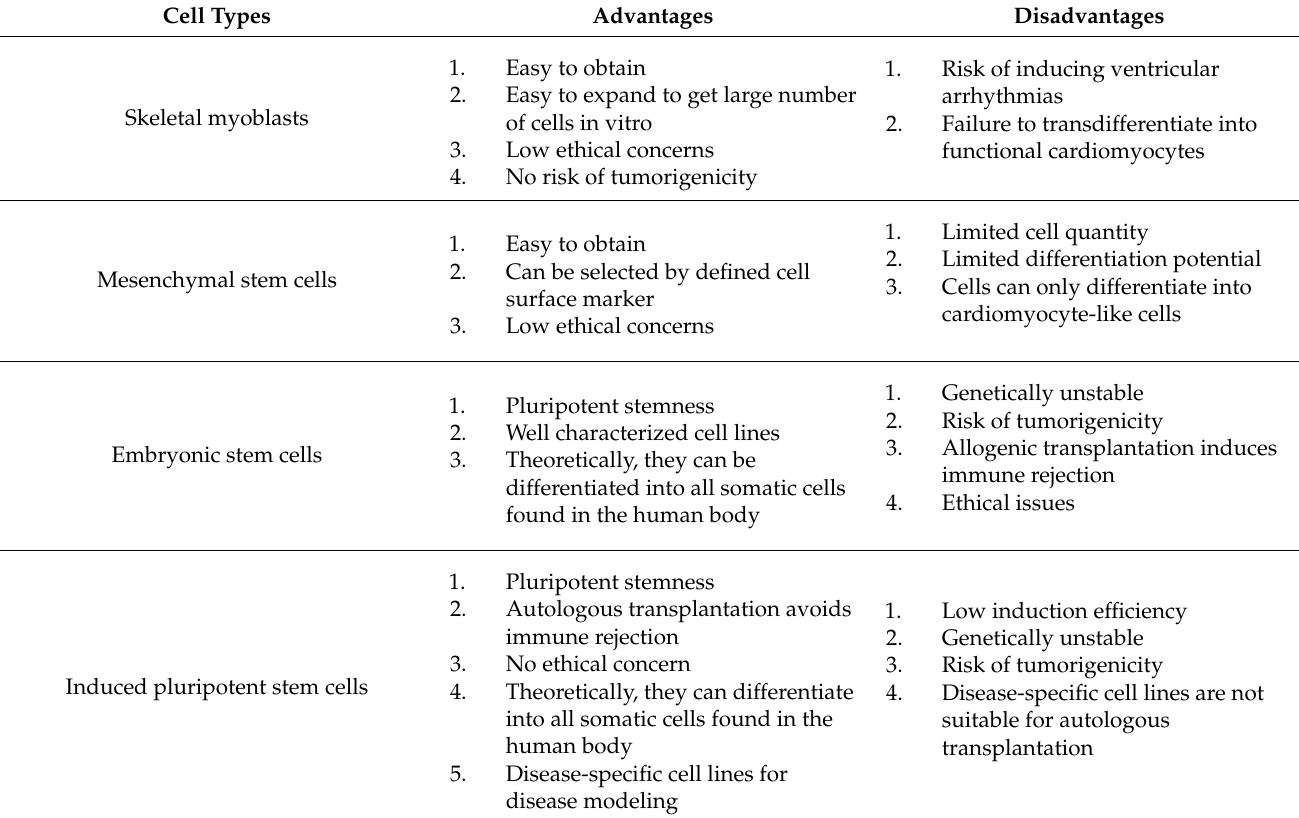
Table 1. Advantage and disadvantages of four types of cells used for cellular cardiomyoplasty. Cell